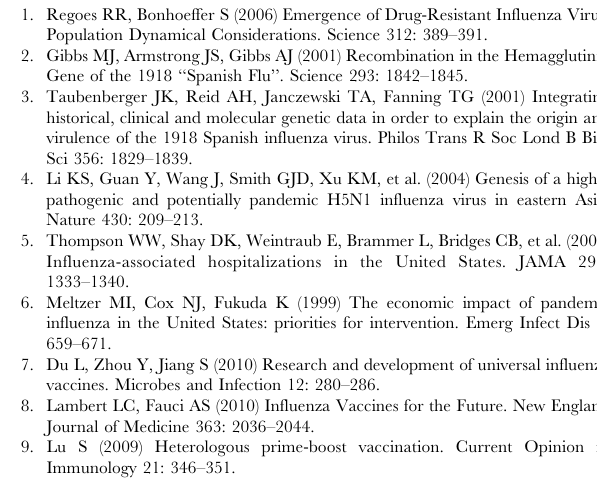
Figure S1 Alignment of nucleoprotein (NP) from various influenza virus subtypes. The NP protein of five influenza virus strains of different subtypes (H1N1, H2N3, H5N1, H9N2, and H7N7, from top to bottom) was aligned. The conserved region, as indicated by red underline, from amino acids 19–498, was used as the backbone for the NPmix multi-epitope protein. (TIF) Figure S2 Alignment of hemagglutinin (HA) and neur- aminidase (NA) from different strains of the H5N1 influenza virus subtype. The NA protein (A) or HA protein (B) from seven or eight different H5N1 viruses were aligned. The conserved N-terminal of NA (amino acids 107–231) and conserved C-terminal of HA (amino acids 347–511), as indicated by red underline, were fused and used for the NA-HA construct along with NPmix in the WR-flu recombinant virus.